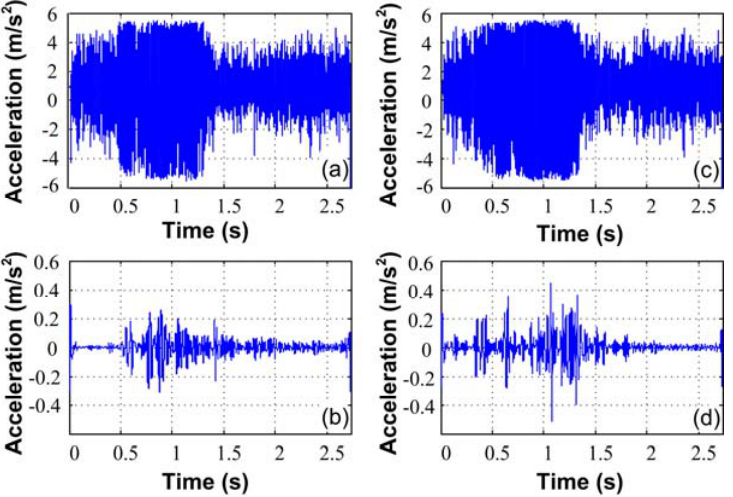
Figure 14. Vibration Signals for induction motor, (a) time-domain signal for healthy motor, (b) DWT reconstruction level 5 for a healthy motor, (c) time-domain signal for a motor with two broken bars, (d) DWT reconstruction level 5 for a motor with two broken